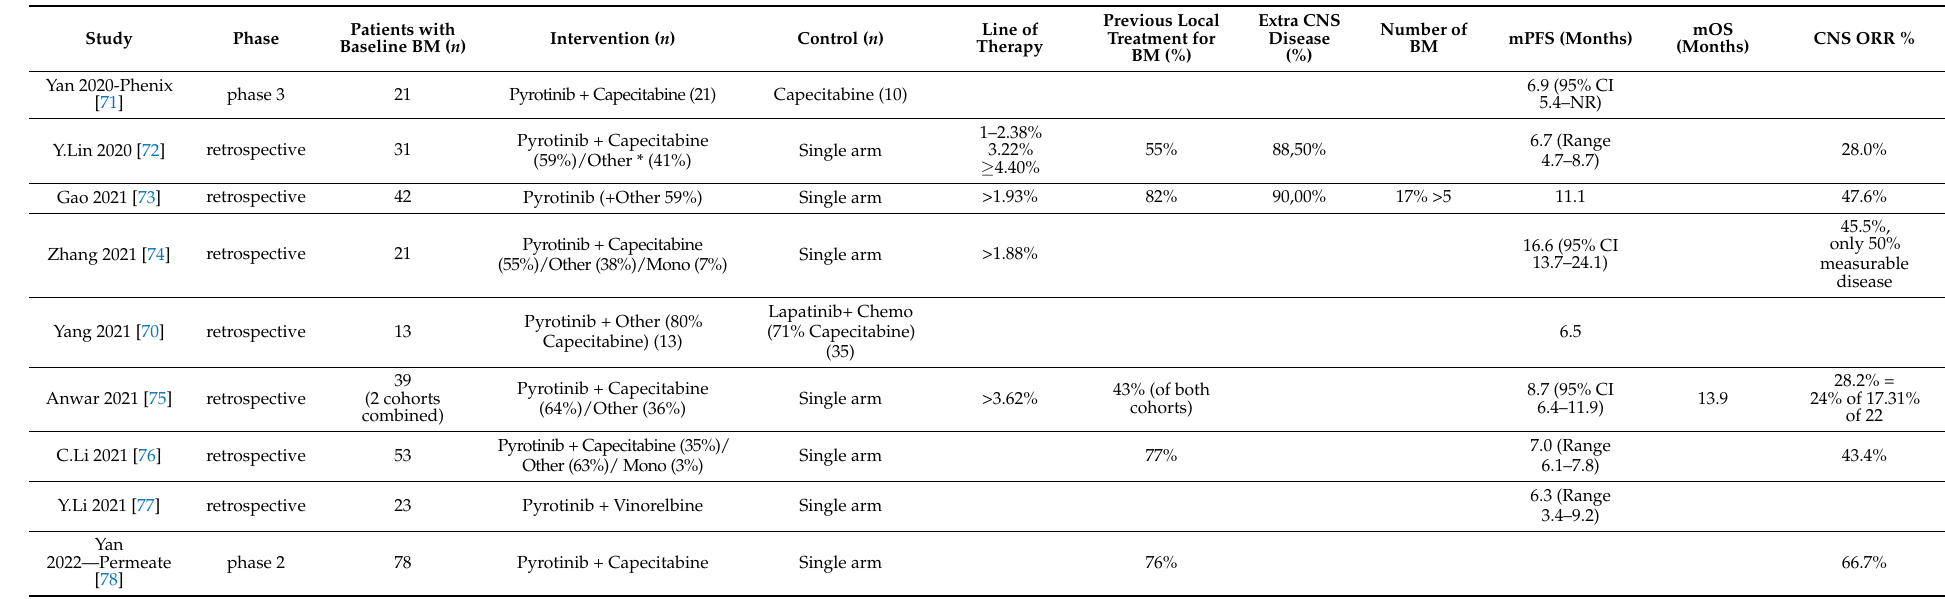
Table 4. Characteristics of included Pyrotinib studies (n =